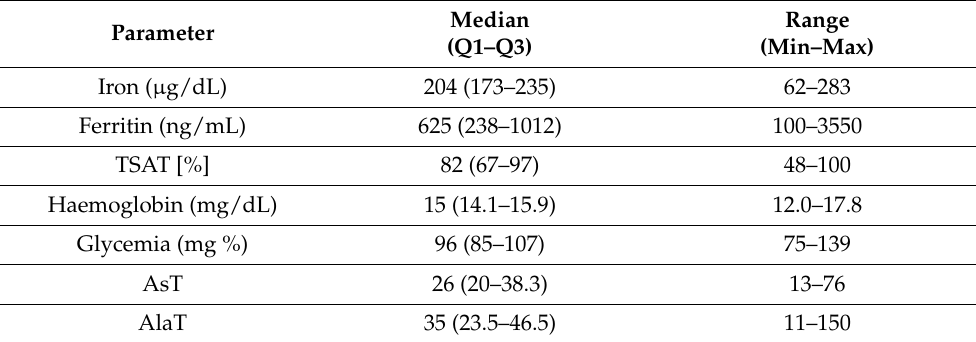
Table 2. Iron turnover parameters in patients. Data are presented as median (25th–75th percentile).